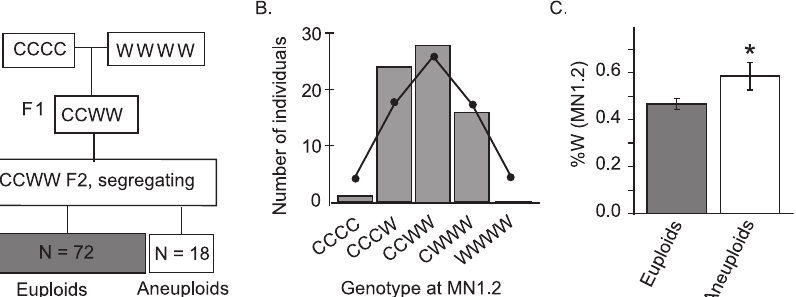
Figure 2. Analysis of Allele Transmission at SDI in a Tetraploid Population (A) Generation of the CCWW F 2 population. (B) Expected (line) and observed (bars) genotype frequencies at the MN1.2 marker in the CCWW F 2 population. (C) The mean percentage of Wa-1 allele at MN1.2 was significantly higher in the aneuploid than in the euploid individuals ( t -test p -value ¼ 0.0396). Standard errors are indicated.